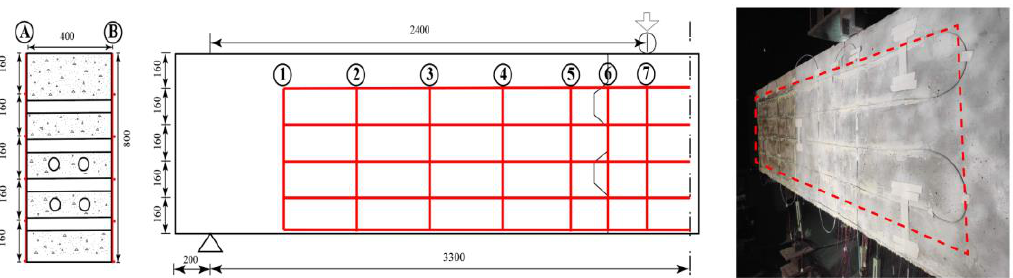
Figure 4. Schematic diagram and picture (side A of the beam showing fiber V1) of fiber optic strain monitoring layout on the cap beam.